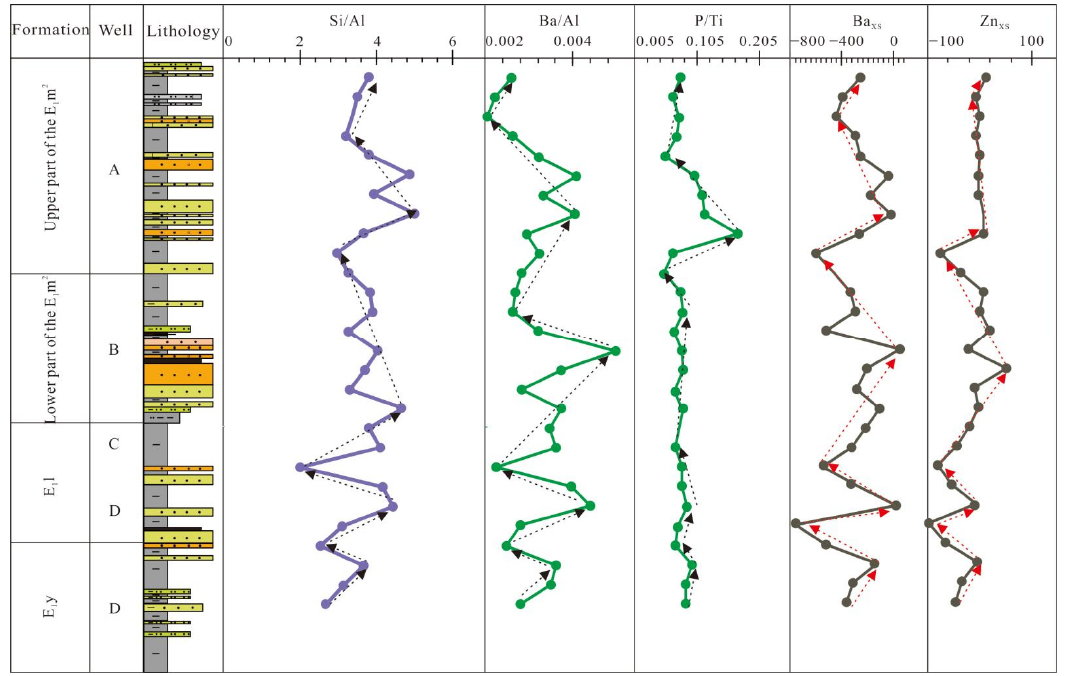
Figure 20. The changing trends of the paleoterrigenous input and paleoproductivity of the Paleocene in the West Lishui Sag.